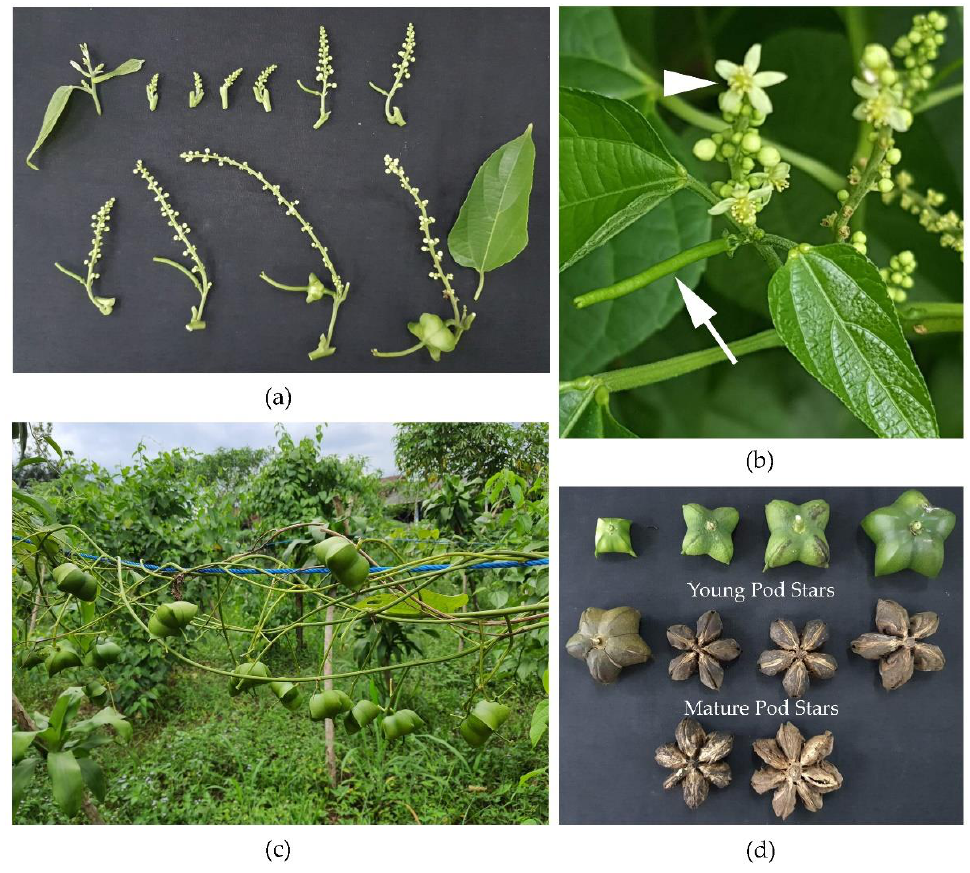
Figure 2. Sacha Inchi flowers and fruits. ( a ) Sacha Inchi flower development. ( b ) Pistillate female (white arrow) and staminate male flower (white head arrow). ( c ) Sacha Inchi plants were fruiting at 3–4 months after planting. ( d ) Young and mature fruit pod stars.